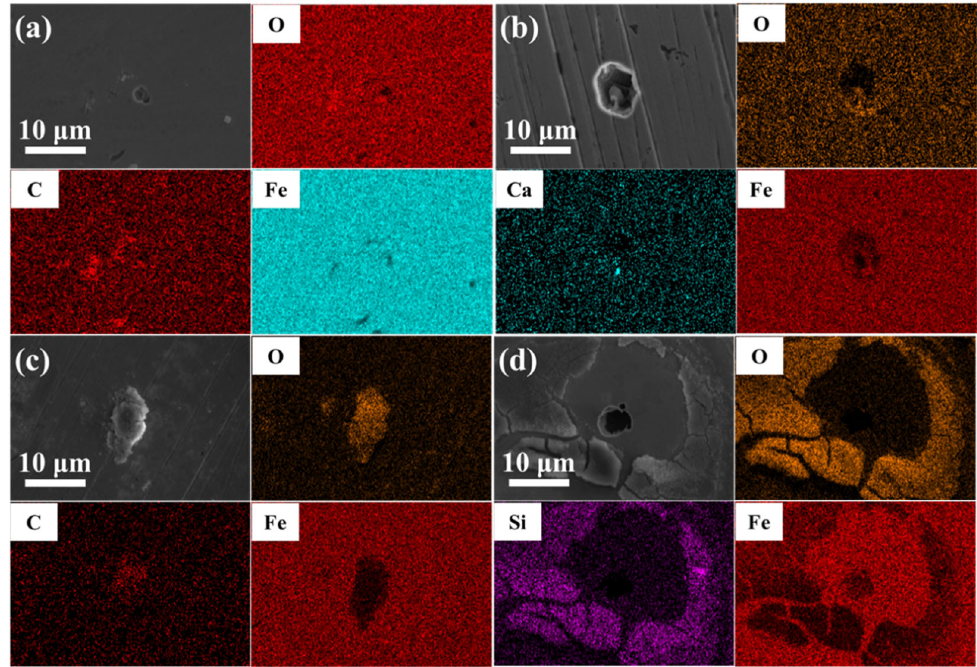
Figure 3. The EDS analysis of 304 stainless steel treated by polarization measurements in different solutions: ( a ) SG; ( b ) SG + CaCl 2 ; ( c ) SG + Na 2 CO 3 ; ( d ) SG + Na 2 SiO 3 .